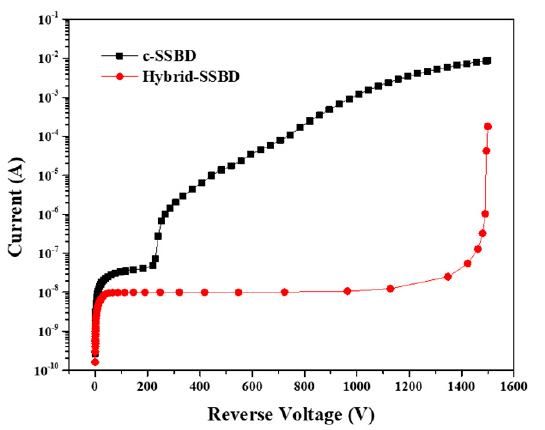
Figure 3. The simulated I − V curve of the two devices; the breakdown voltage is the current at rapidly rising points.